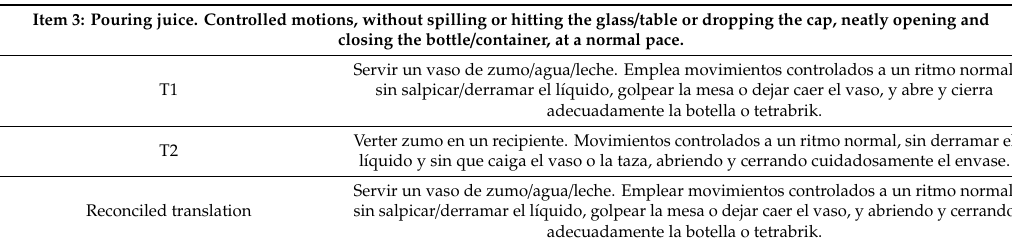
Table A1. Example of items reconciliation and